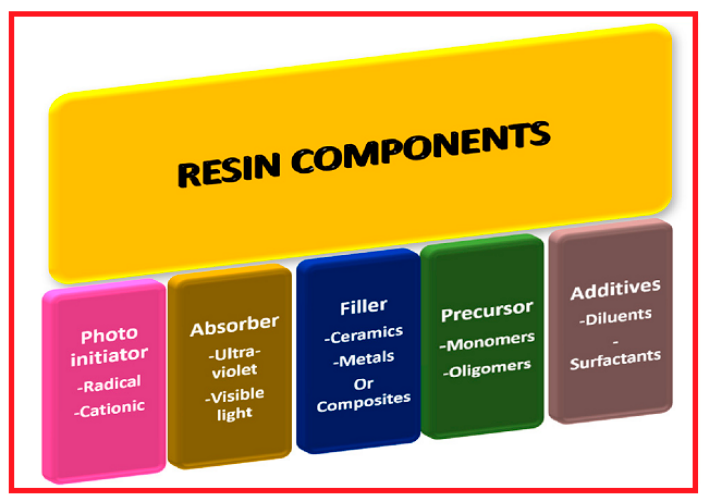
Figure 5. Resin components in stereolithography (SLA) [29].